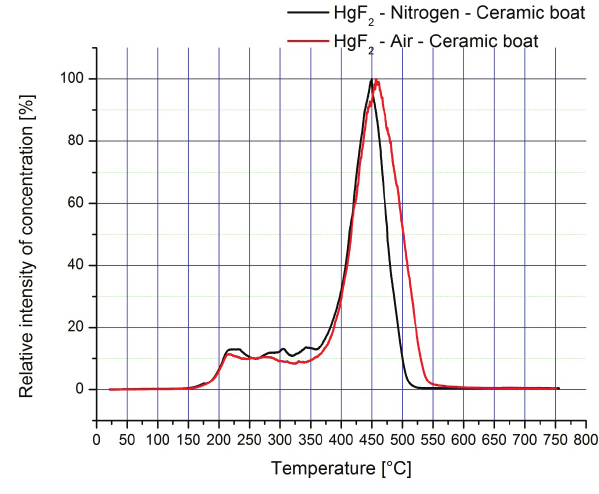
Figure 28: Thermograms of HgF